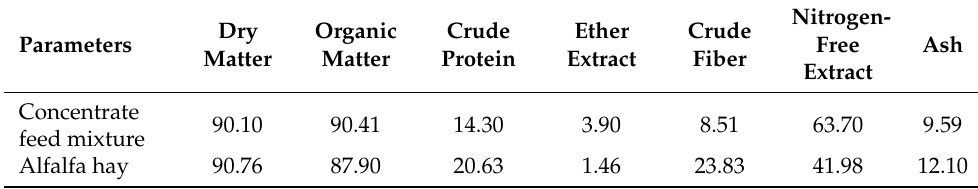
Table 1. Chemical composition of experimental diets on dry matter basis